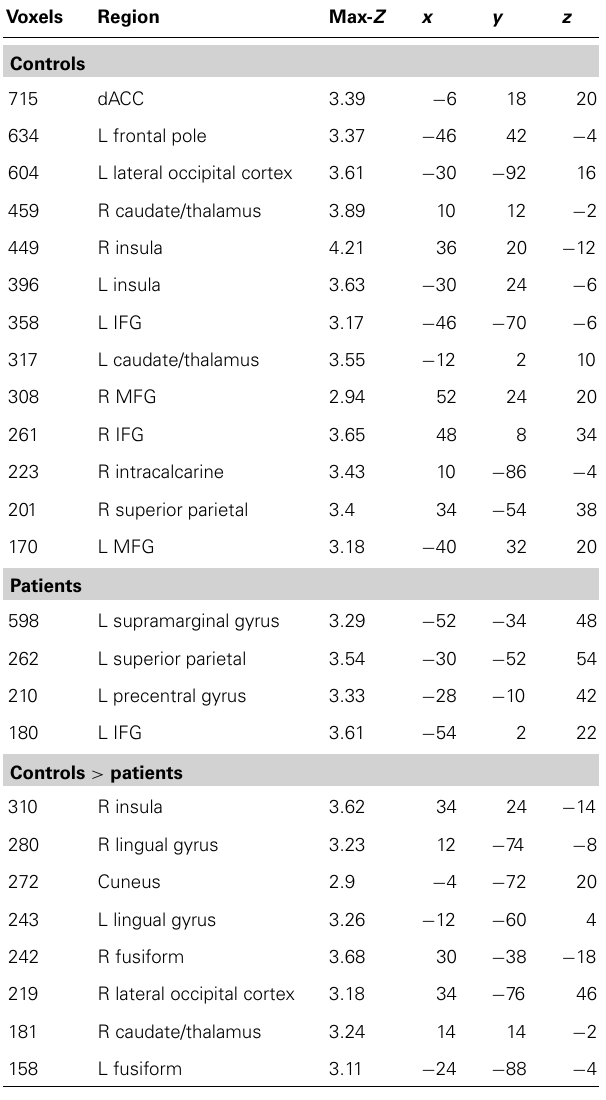
Table 3 | HIT > MISS whole-brain significant